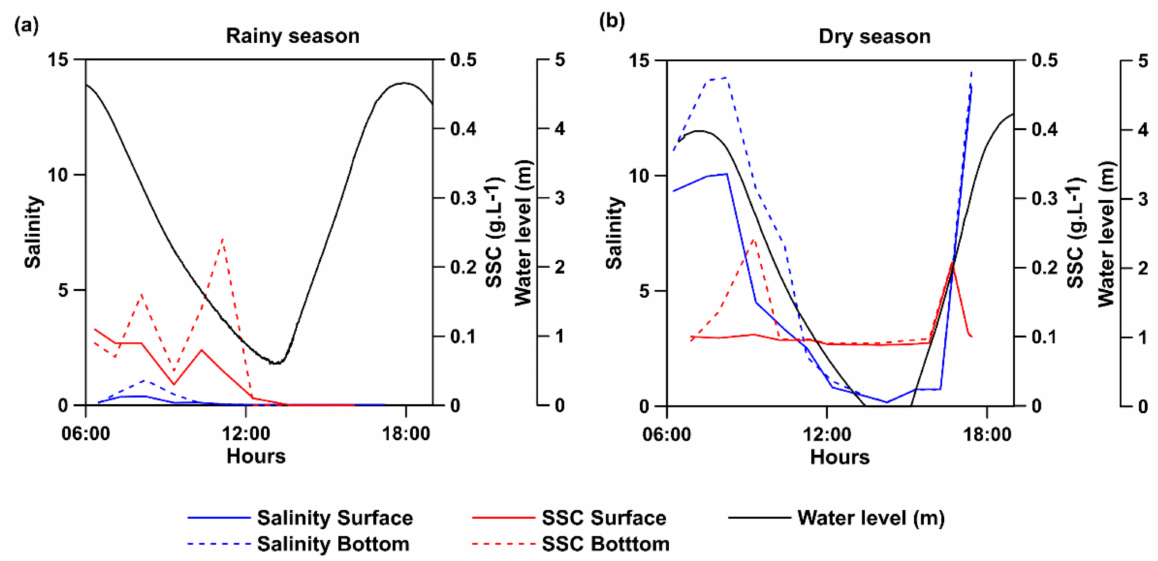
Figure 5. Hydrodynamics in the cross-sectional area comparing the salinity and SSC data during the rainy ( a ) and dry ( b ) seasons. The blue line shows the salinity level at the water surface (solid line) and bottom (dashed line). The red line shows the SSC data at the water surface (solid line) and at the bottom (dashed line).